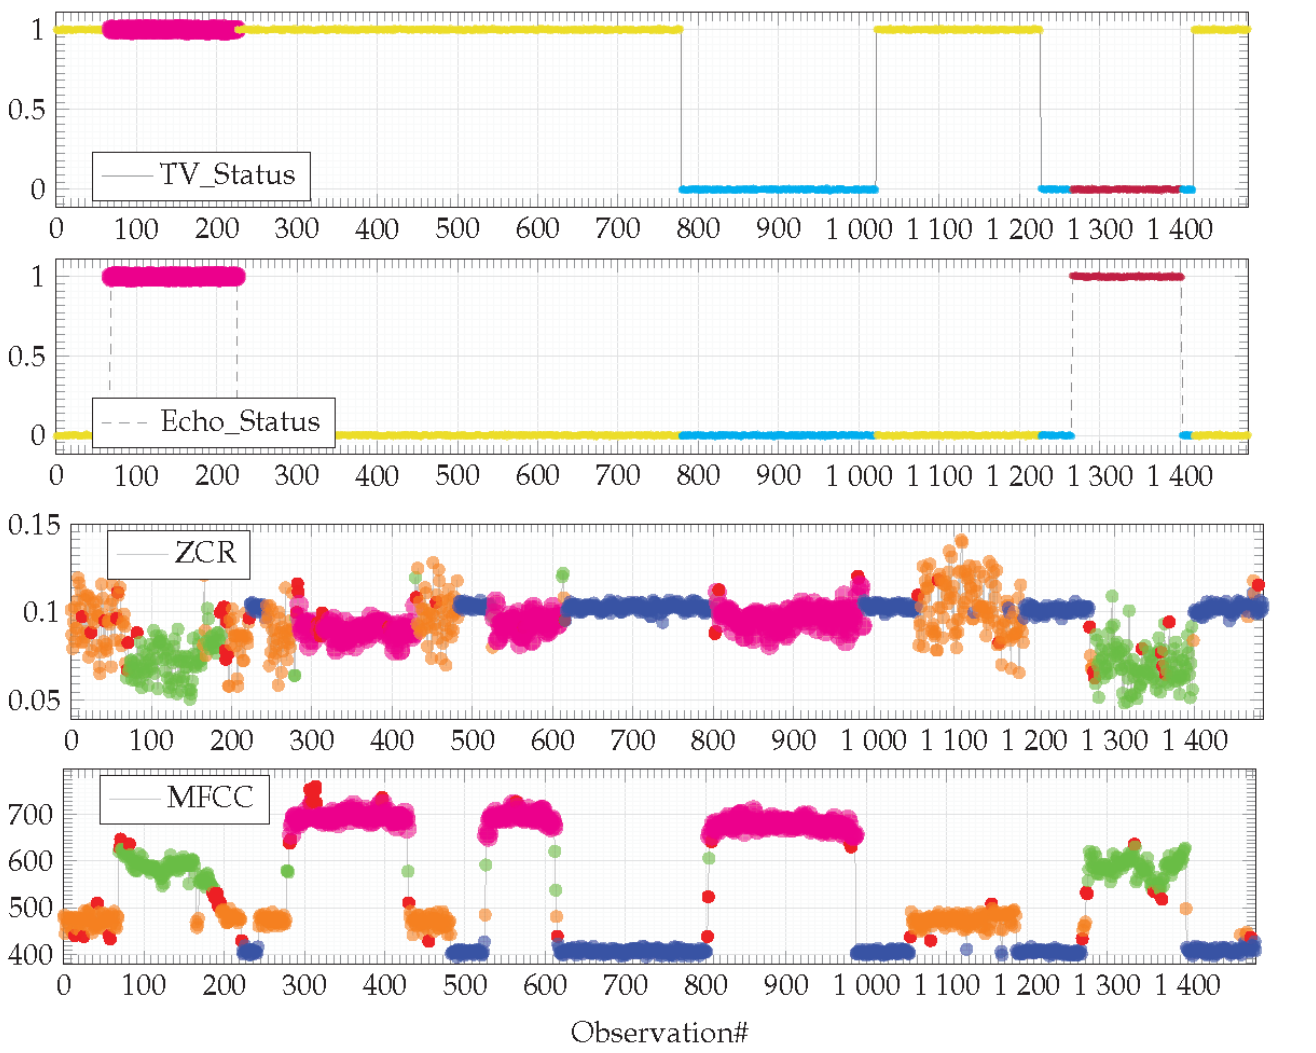
Figure 8. Observations from the field colored according to the clusters identified by the FISHDBC algorithm with min_samples = 40. Observations colored in magenta denote behaviors not anticipated/foreseen in the model of the legitimate behavior depicted in Figure 7, learned on the basis of the dataset depicted in Figure